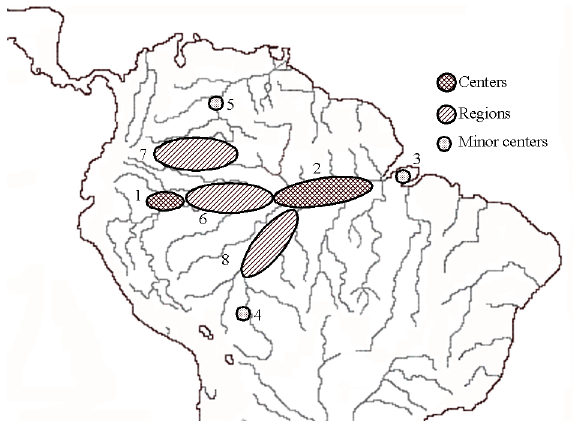
Figure 4. Centers, regions and minor centers of crop genetic resources diversity at the time of European conquest (modified from [7]). Centers of diversity: 1―western